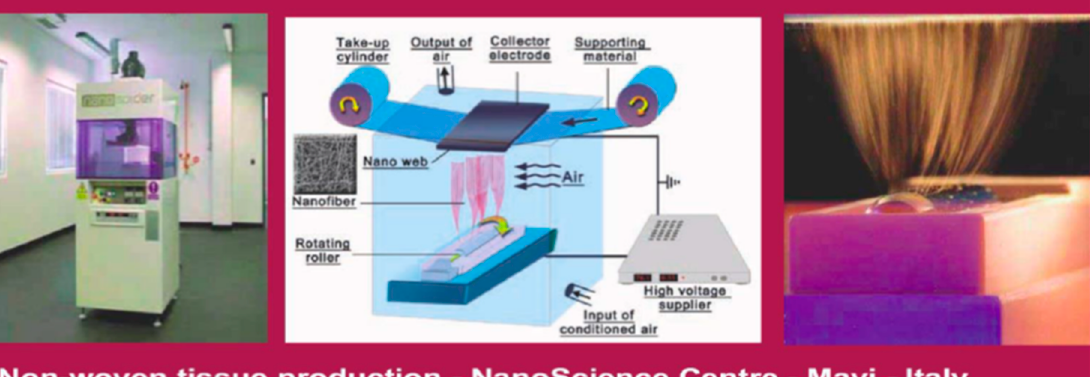
Figure 10. Electrospinning technology.